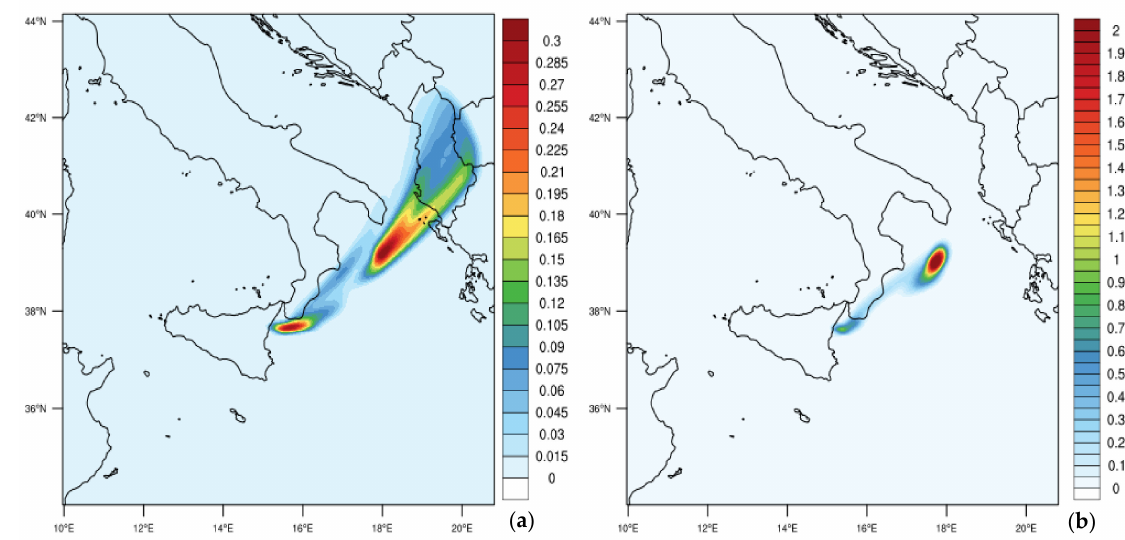
Figure 8. WRF-Chem SO 2 spatial pattern at 12:00 UTC of 23 November 2013 for ( a ) run1 with constant ESP during the whole eruptive episode and ( b ) run2 that uses time-varying ESP obtained from video (plume height) and V2B Doppler radar (MER)